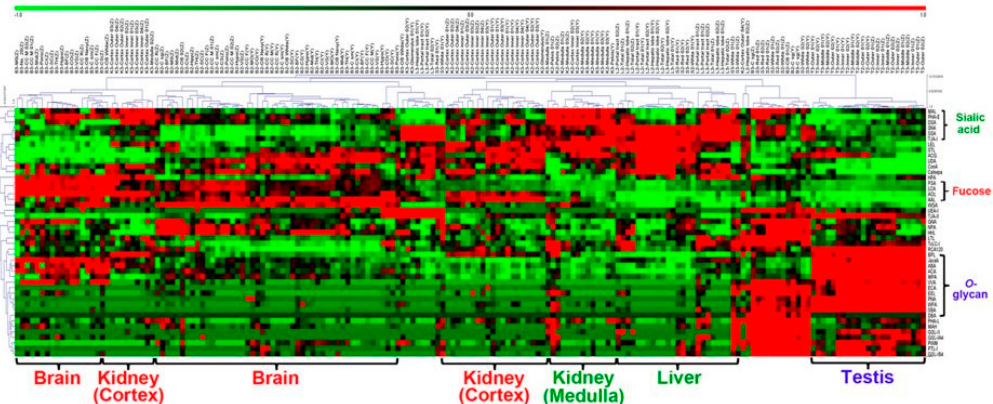
Figure 5. Two-dimensional analysis of the normalized lectin microarray data from the 182 tissue fragments. The 182 samples are listed in columns and the 45 lectins are listed in rows. The colour and intensity of each square indicate the lectin signal levels in specific tissue fragments (Red, high; green, low; black, medium). Reprinted from ref. [123].